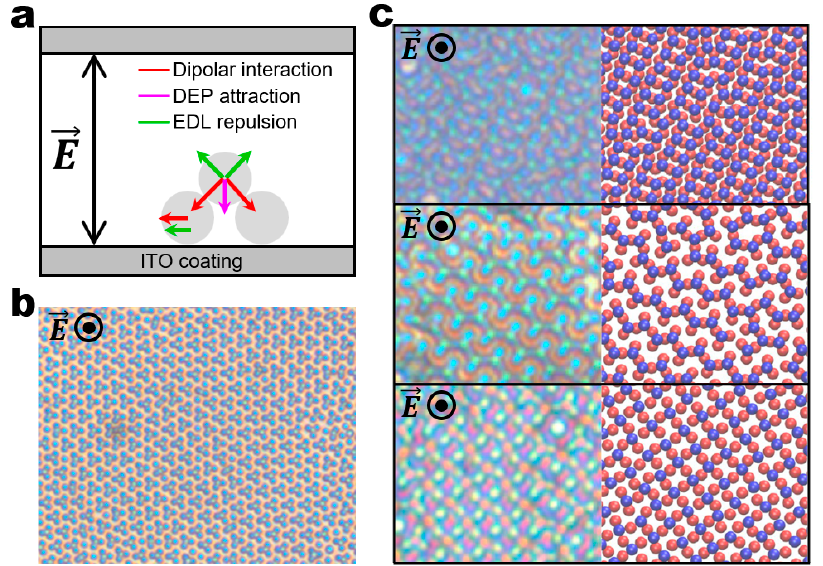
Figure 5. Field-driven dynamic structuring in a vertical electric field with low frequency and low salt concentrations. ( a ) Schematic illustrating the key forces acting on the system. Reproduced with permission [20]. Copyright 2013, American Chemical Society. ( b ) A large array of tetramers assembled from 1.2 µm spherical polystyrene particles. Scale bar: 10 µm. Reproduced with permission [20]. Copyright 2013, American Chemical Society. ( c ) Experimental (left) and simulation (right) results of rectangular bands (top), zig-zag stripes (middle), a sigma lattice (bottom) assembled from 1.2 µ m spherical polystyrene particles. Reproduced with permission [50]. Copyright 2021, American Chemical Society. The circle and dot with the electric field denote that the field is applied perpendicular to the plane of view in ( b , c